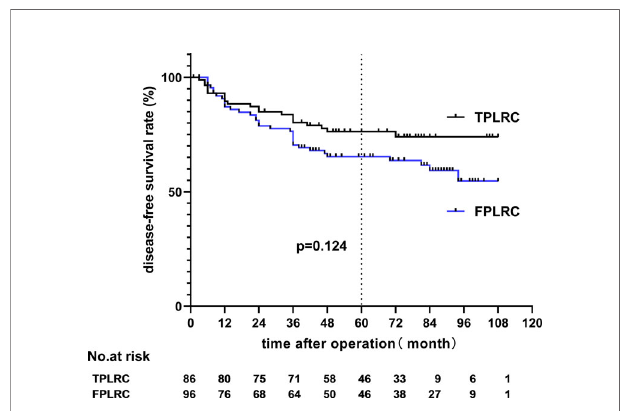
FIGURE 5 | Disease-free